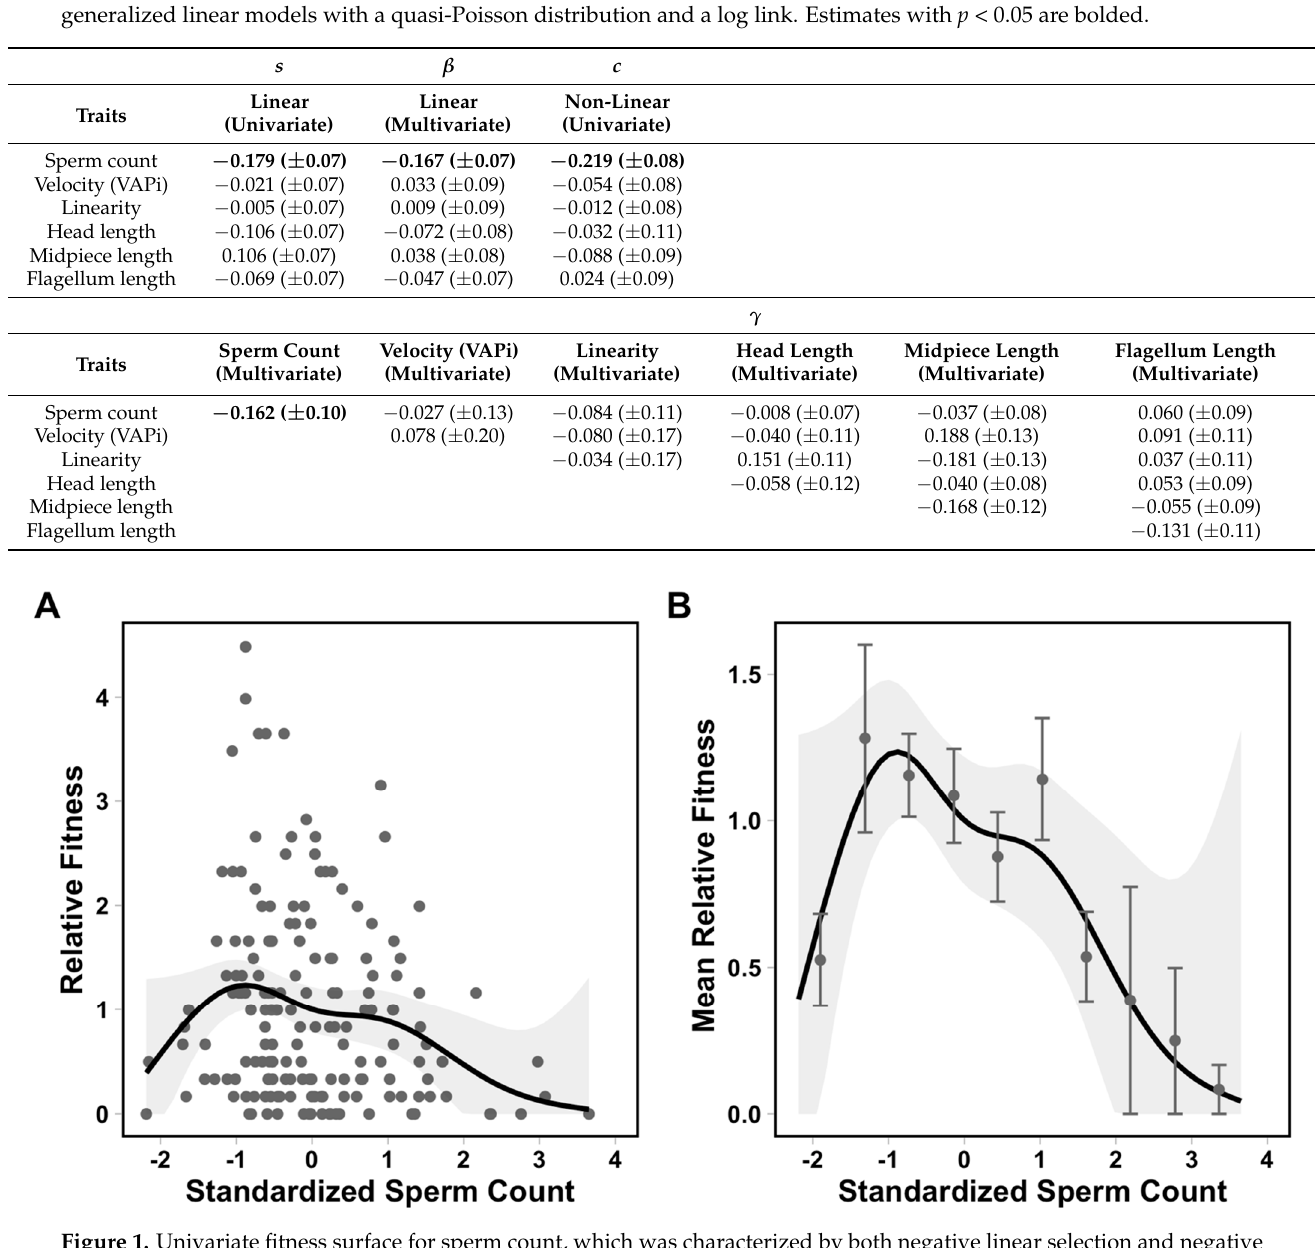
Figure 1. Univariate fitness surface for sperm count, which was characterized by both negative linear selection and negative quadratic selection. In both plots, the solid line represents the predicted relative fitness from the GAM model with the best fit (K = 6; Supplementary Materials Figure S1), and the grey shaded area represents the 95% confidence interval of the model prediction. Panel ( A ) shows each individual male as a data point, while panel ( B ) summarizes males into 10 bins of approximately equal size, with mean ± SE for each group to better visualize the fitness surface.